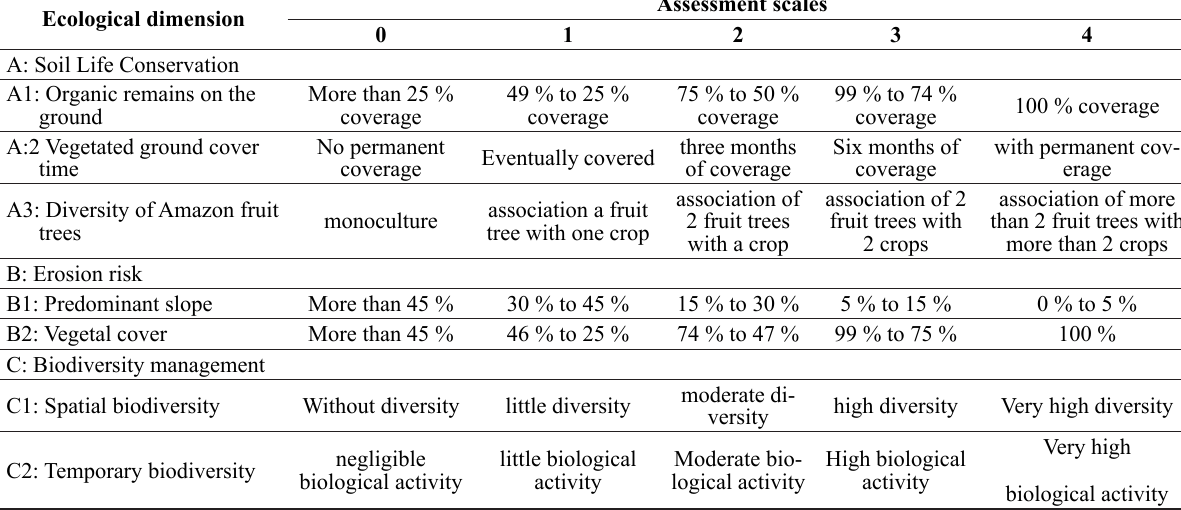
Table 2: Sub-indicators, variables and valuation scales to evaluate the ecological sustainability of plots producing Amazonian fruit trees on the Iquitos - Nauta highway Ecological dimension